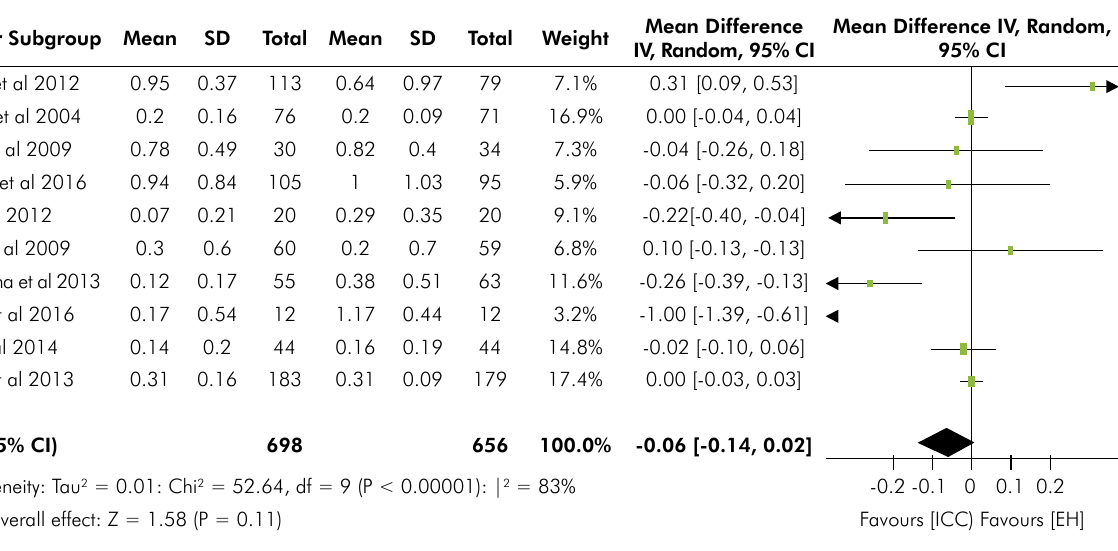
Figure 3. Marginal bone loss after 1